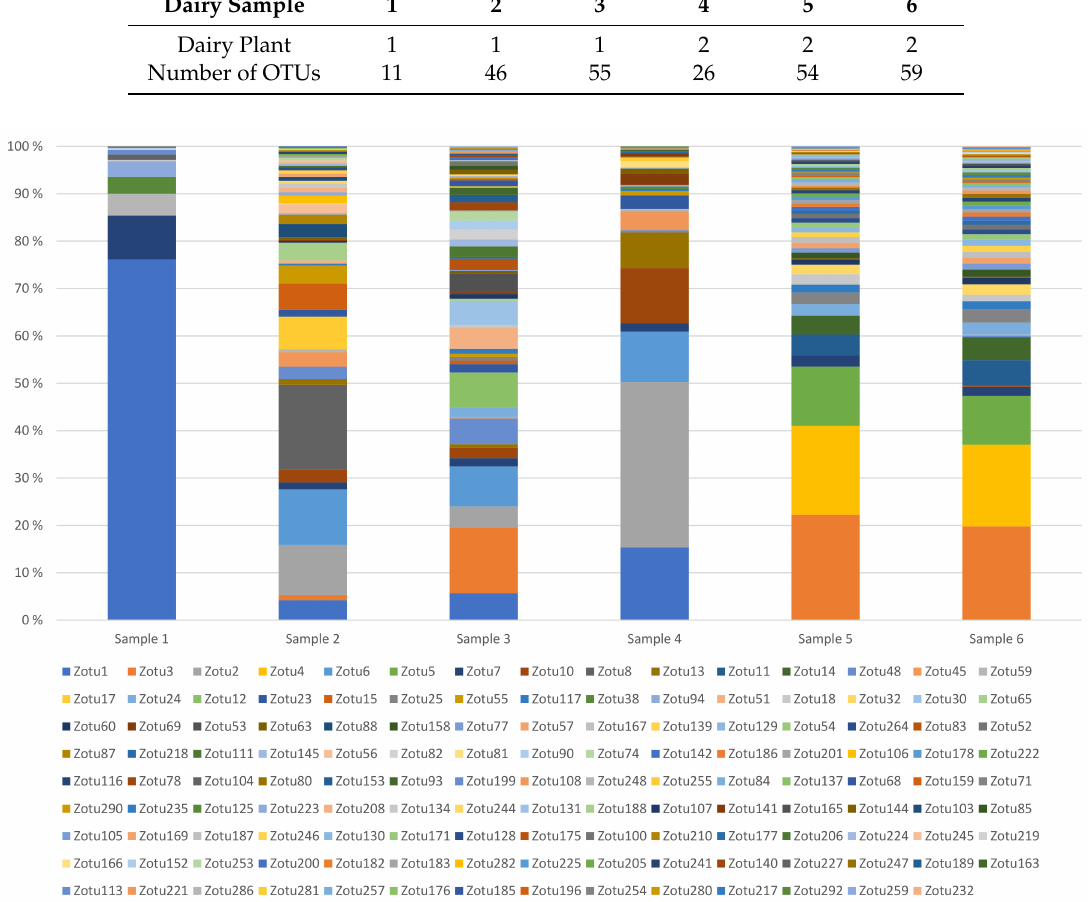
Figure 2. Bacteriophage diversity in six dairy samples using targeted amplicon sequencing of the portal protein gene. The samples were acquired from two separate dairy facilities. Samples 1–3 are from one location, while samples 4–6 are from a second location. Sample 5 and 6 are produced using the same starter culture